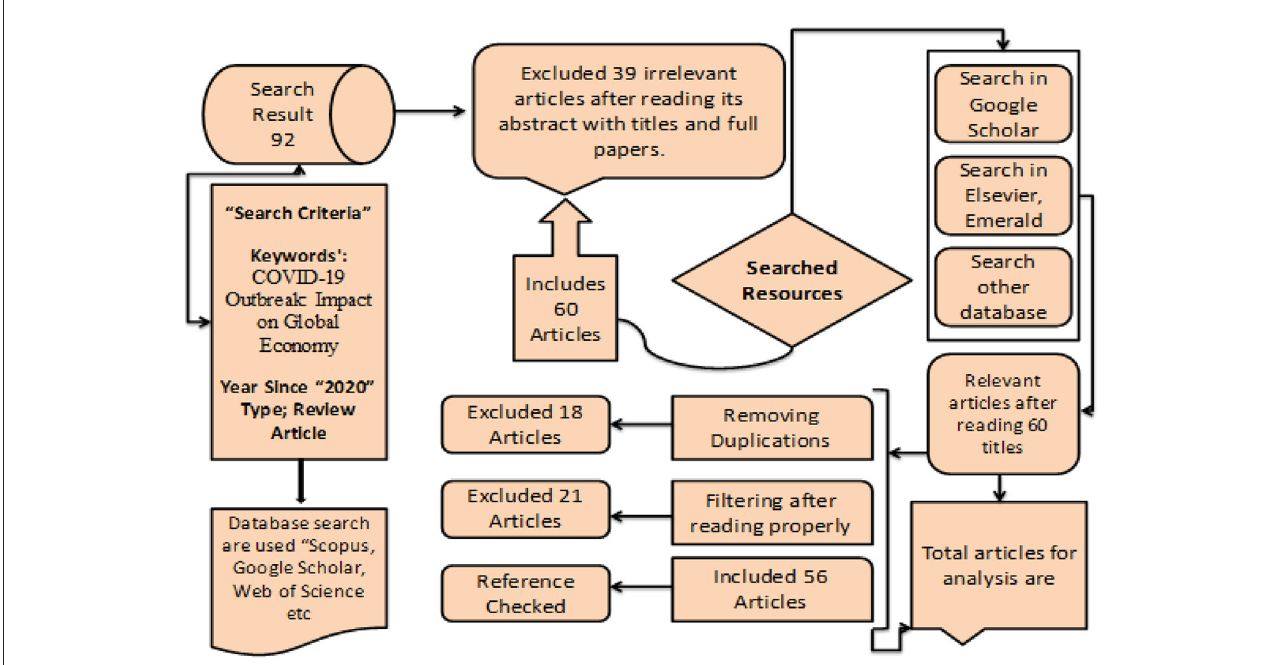
FIGURE3 Methodology search for finalized articles for investigations. Source: Author’s constructed.